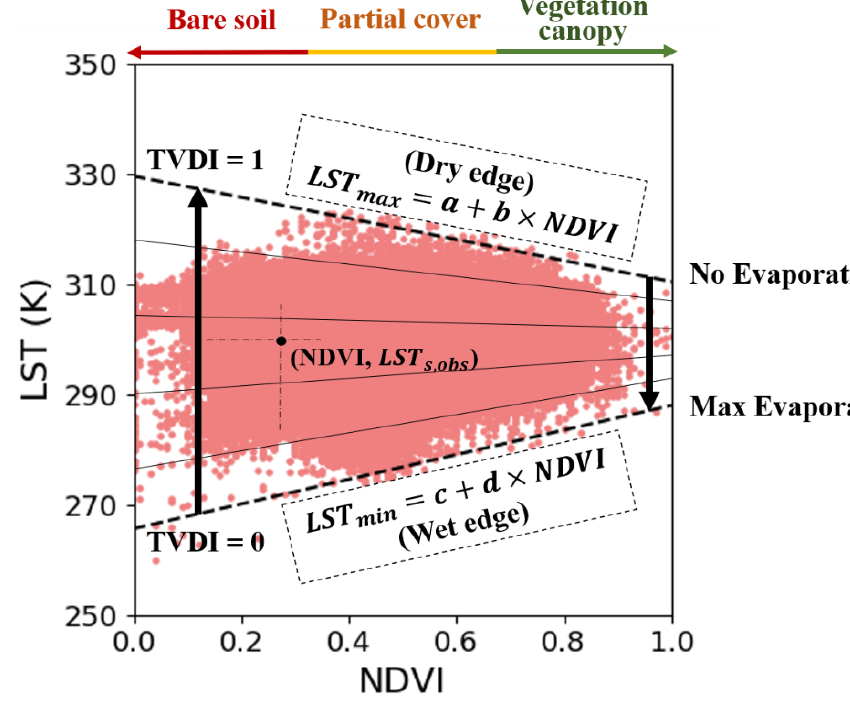
Figure 2. Example of a TVDI distribution and its characteristics in NDVI / LST space. Two edge lines LST max and LST min in the LST/NDVI space are expressed as follows [33,40,42]: